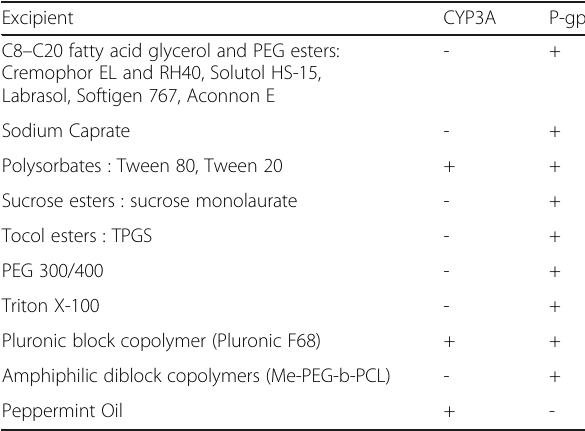
Table 2 Examples of Excipients Inhibiting In Vitro/In Vivo Metabolic Enzymes and Membrane Transporters (Chen 2008; Constantinides et al.